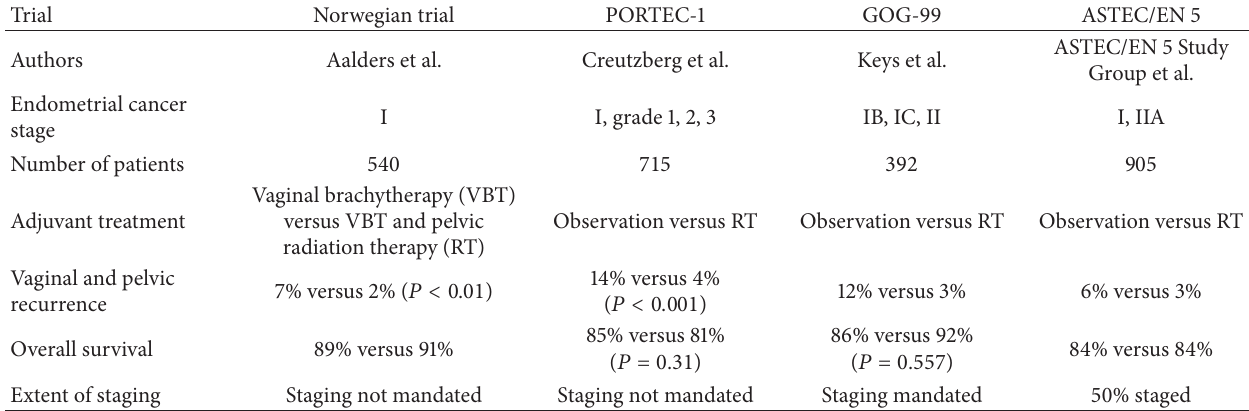
Table 5: Randomized trials of adjuvant radiation therapy in early-stage endometrial cancer.